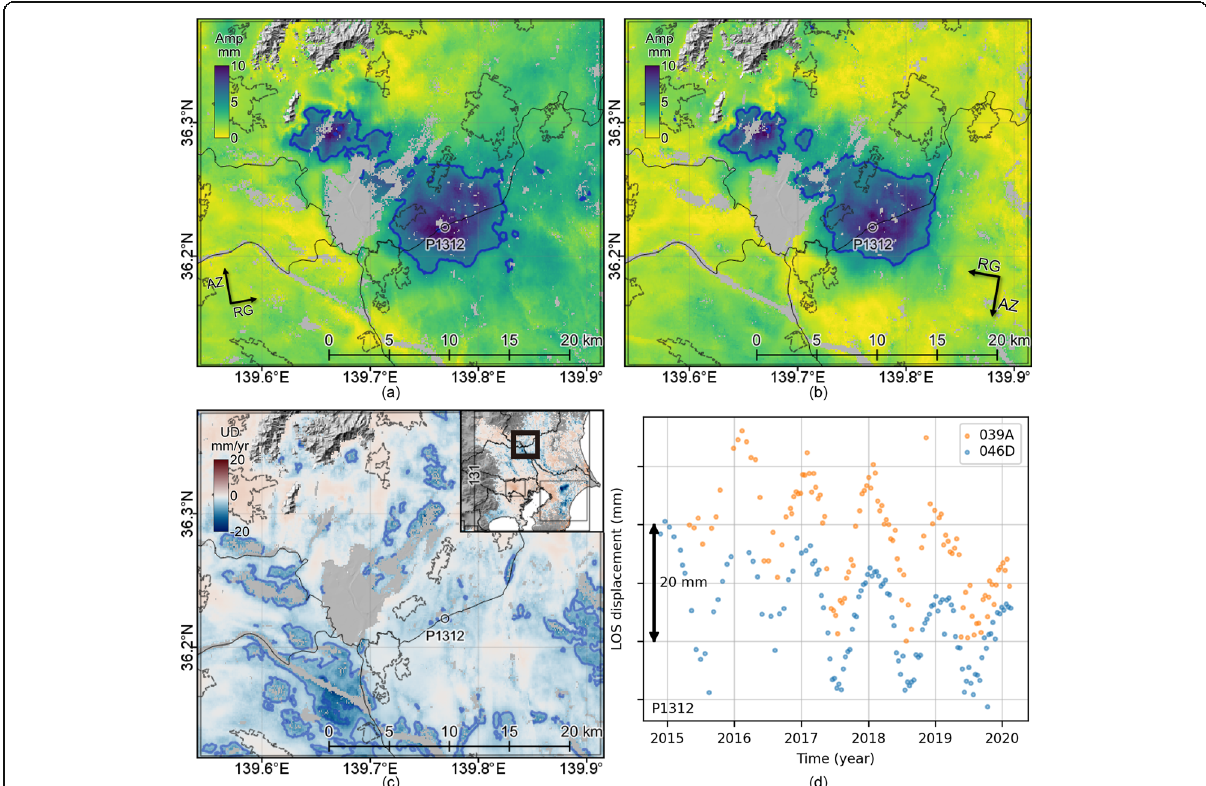
Fig. 9 a Amplitudes of the annual LOS fluctuation in Nogi (ID: 131, Tochigi in Kanto) from the ascending 039A_05372_151515. The black lines denote the borders between prefectures. The interval of the contour lines is 5 mm. b Amplitudes from the descending 046D_05292_131313. c Vertical deformation velocities. The interval of the blue (subsidence) contour lines is 5 mm/year without the 0 mm/year lines. The inset denotes the whole area of the 131 Kanto. d LOS deformation time series at P1312 for each